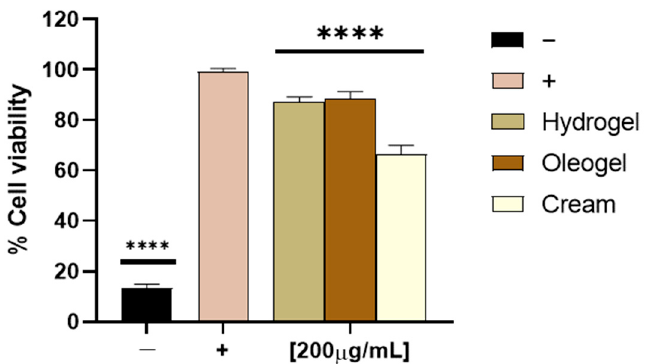
Figure 8. Cytotoxic activity of formulations. Cell viability was evaluated by MTT assay after Vero cell treatment with each olive-derived formulation for 24 h at 200 µ g/mL OFE. Non-treated cells were used as the positive control (+), whereas DMSO was used as the negative control ( − ). Statistical analyses were determined by one-way ANOVA with Dunnett’s test for multiple comparisons. Significances are referred to as the untreated cells (+). **** p < 0.0001.